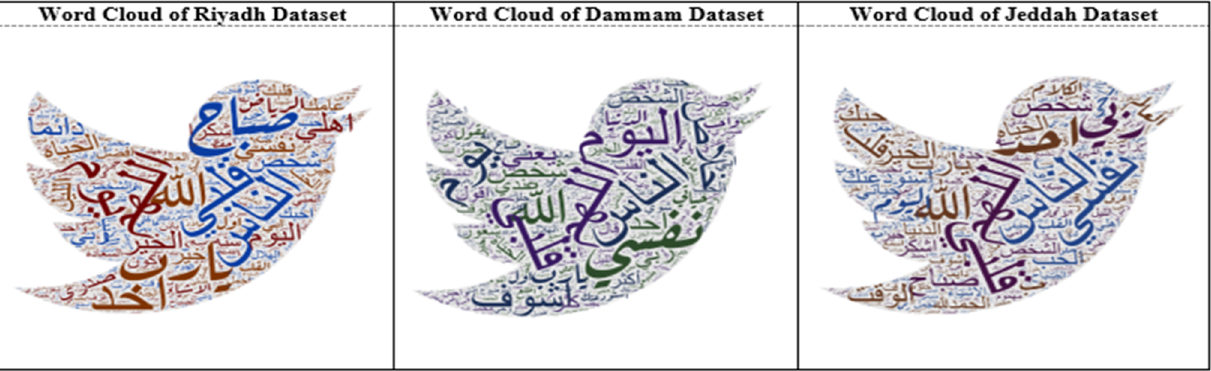
Figure 16. Word Clouds of datasets before COVID-19. Table 10. Distribution of sentiment classes for (before COVID-19) dataset.